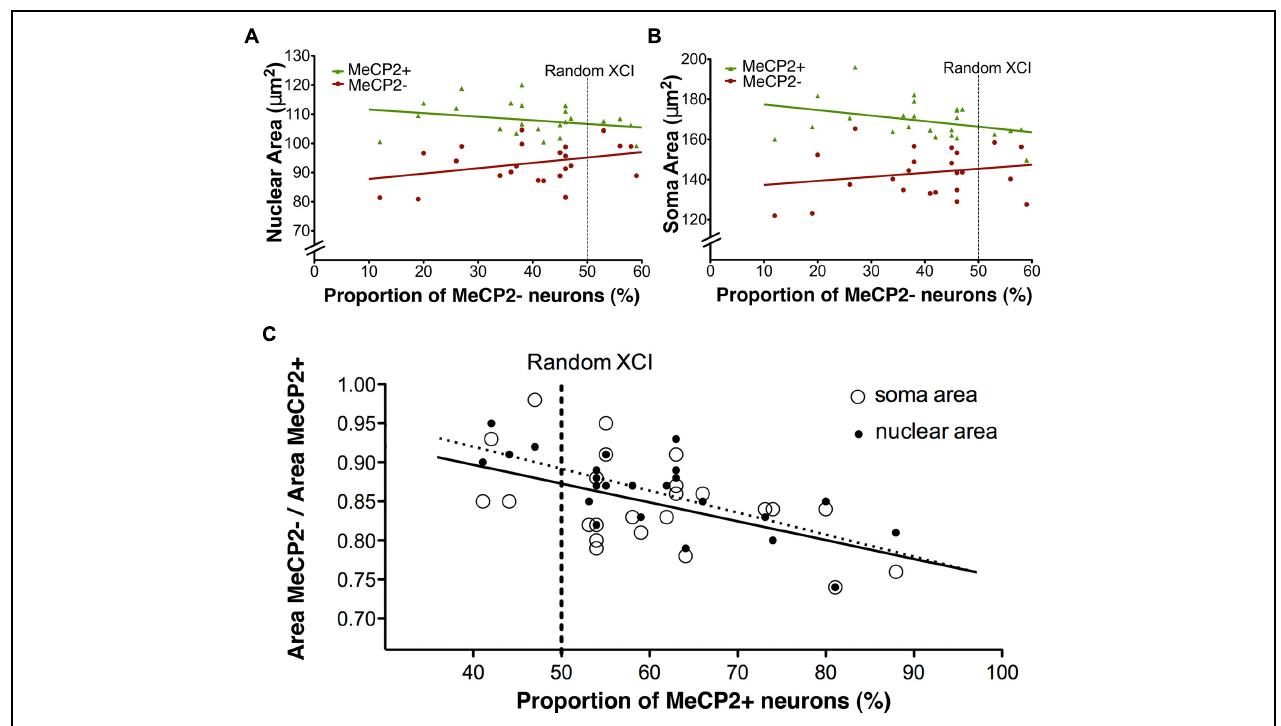
FIGURE 10 | Nuclear and soma areas are correlated with XCI ratios. (A) Nuclear areas of MeCP2 + and MeCP2 − neurons diverge as XCI ratios become more skewed in favor of MeCP2 + expression (right to left). Slopes are significantly different between the genotypes ( p = 0.04, MeCP2 + R 2 = 0.069 and MeCP2 − R 2 = 0.11). (B) Soma areas of MeCP2 + and MeCP2 − neurons appear to diverge as the proportion of MeCP2 − neurons in the brain decreases (right to left). Slopes are not significantly different between the two genotypes